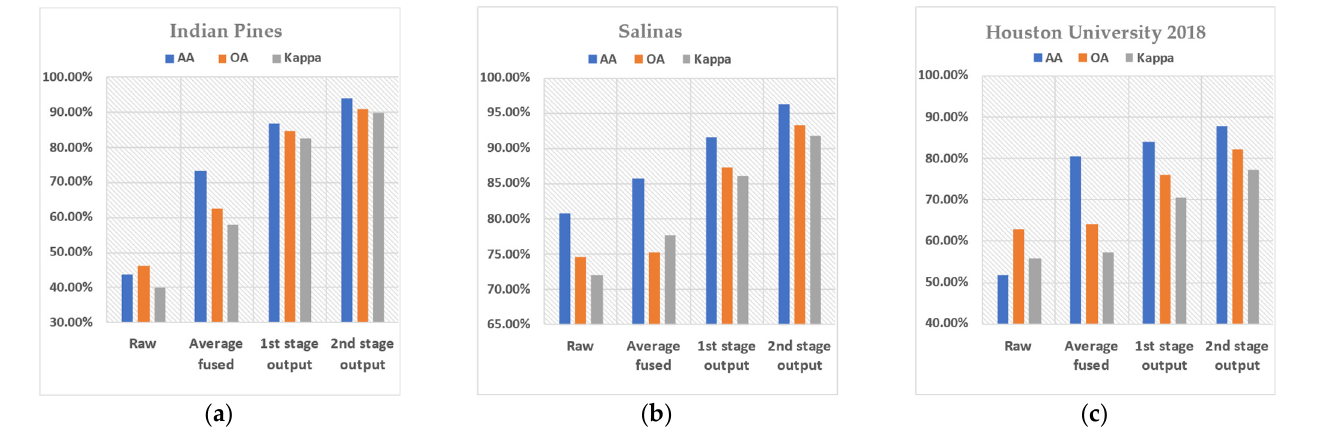
Figure 11. Classification performance of the SVM on the raw data, the average fusion data, and the output feature blocks of the first and second stages for the three datasets. ( a ) Indian Pines; ( b ) Salinas; ( c ) Houston University 2018.